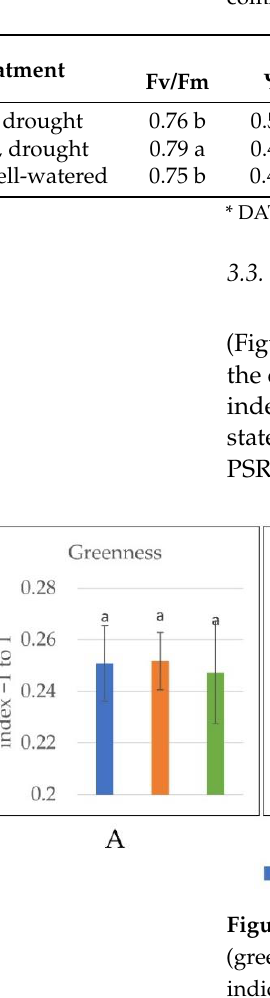
Figure 4. Morphological parameters observed 4 DAT by the LLPhP (scanning platform). ( A ) Digital biomass, ( B ) height, ( C ) leaf angle, ( D ) LAI (leaf area index), ( E ) leaf inclination, ( F ) leaf area. For each trait, at least one letter in common indicates no significant difference. 3.4. Effect of the Treatment on Metabolomic Profiles under Drought Stress Conditions An untargeted metabolomics approach was performed using a hybrid quadrupole time-of-flight mass spectrometer coupled to a UHPLC chromatographic system (UHPLC- ESI/QTOF-MS) to investigate plants ’ metabolic responses induced by the 4-Vita treatment